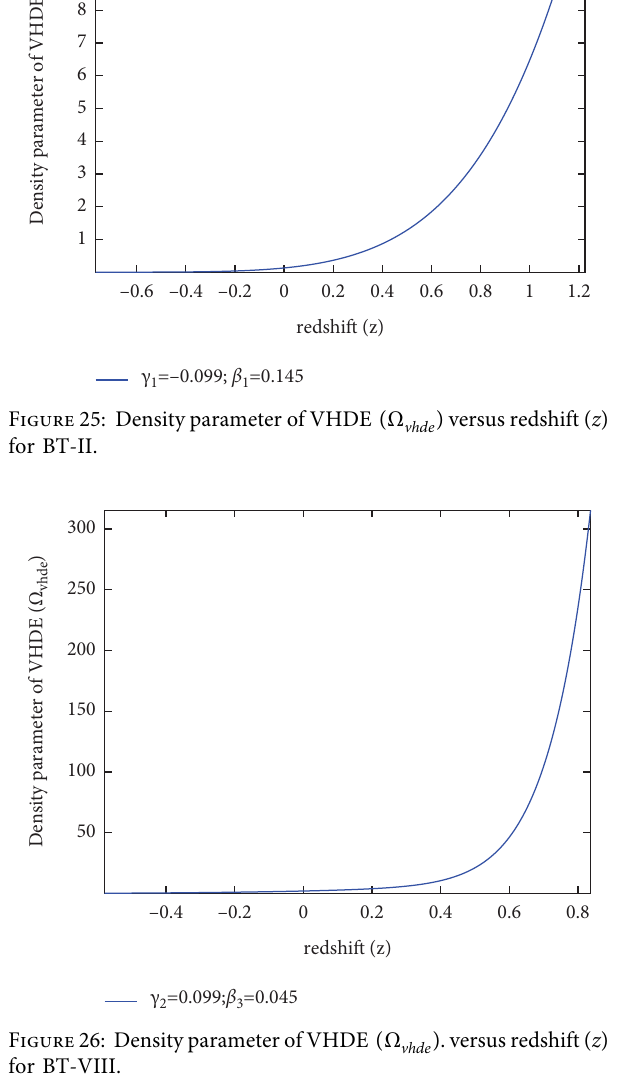
Figure 26: Density parameter of VHDE ( Ω for